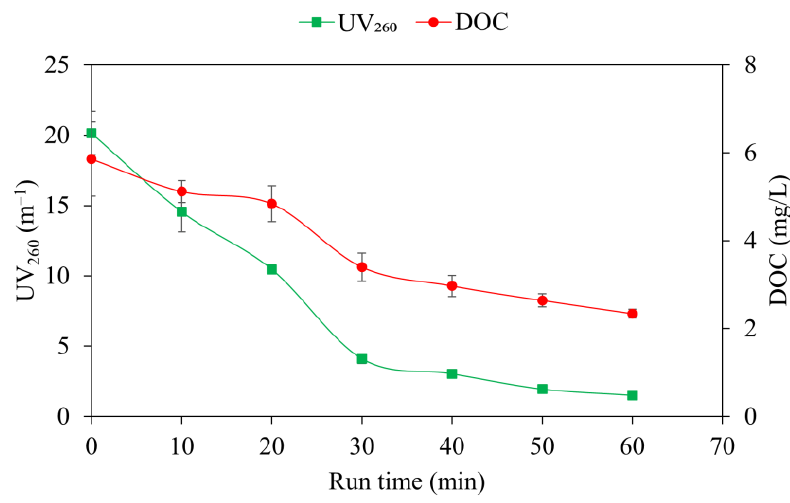
Figure 3. The reduction of UV 260 and DOC during RF treatment ( n = 8).